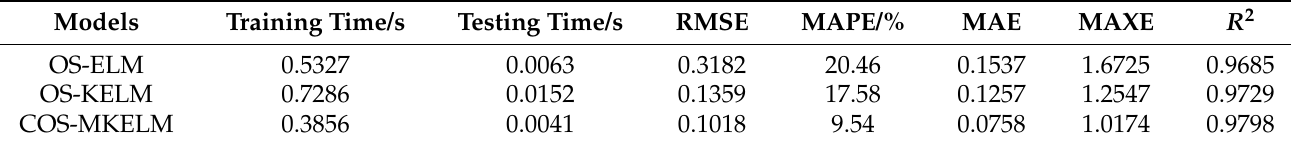
Figure 7. Simulation result of fCaO online prediction model with COS-MKELM for testing data. Table 3. Performance comparison of the fCaO content online prediction